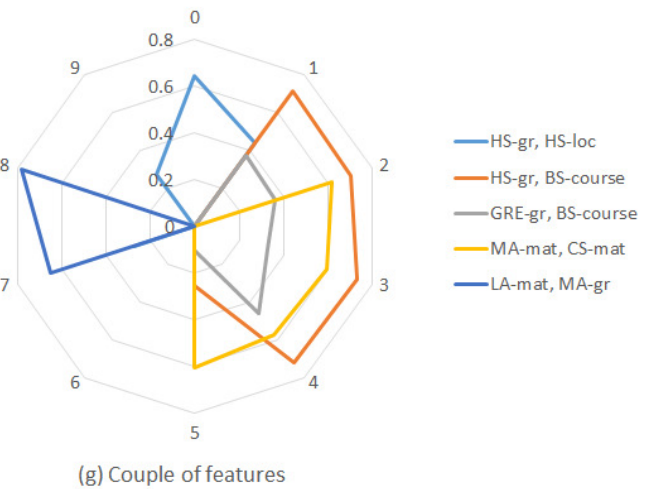
Figure 5. LA: Analysis of the relevance of pairs of features.